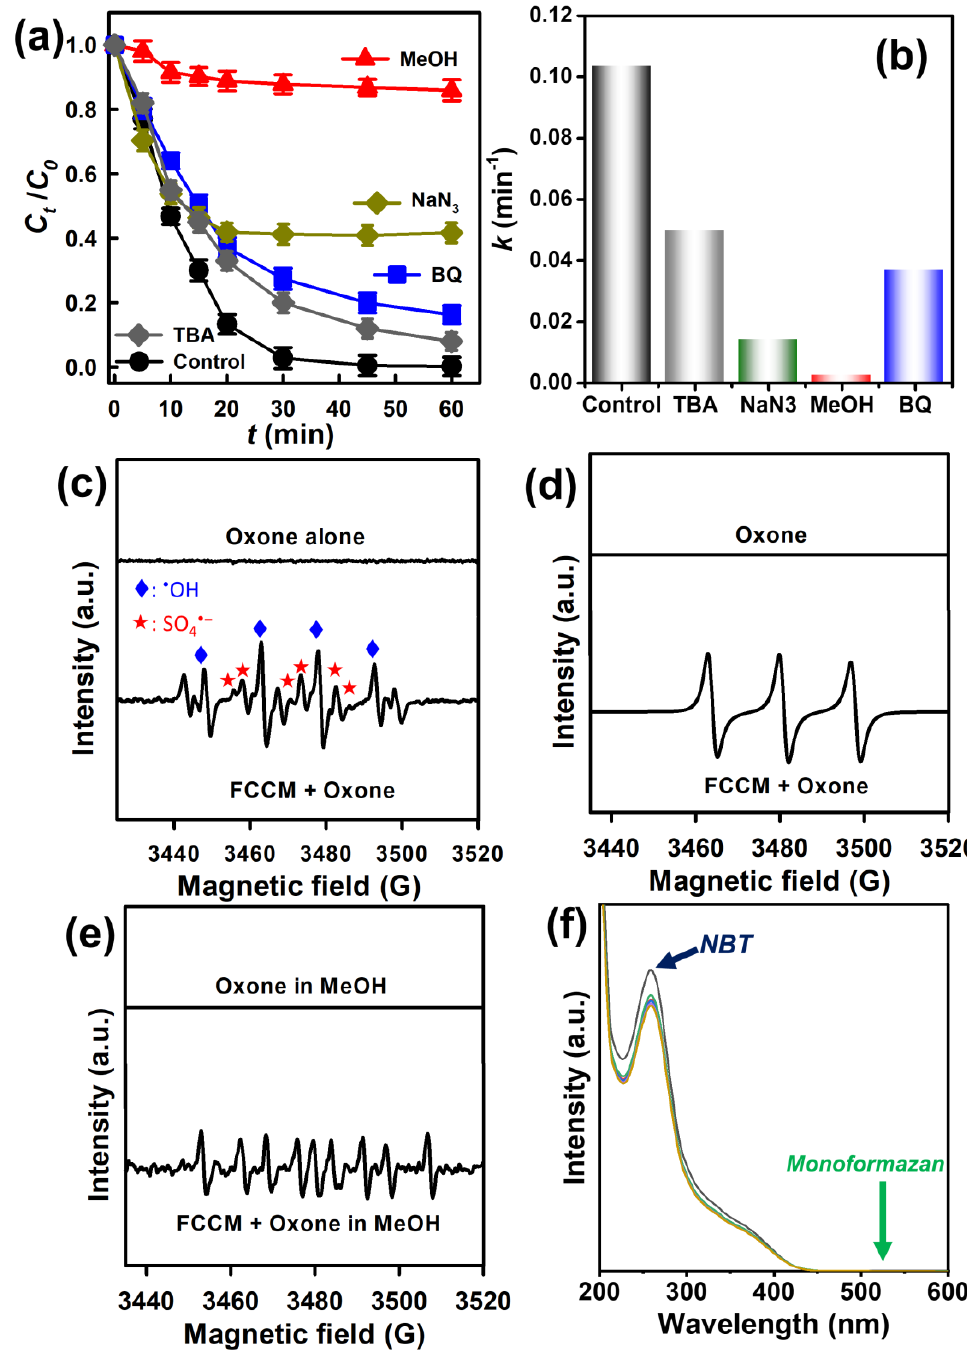
Figure 8. Effects of radical probe on the degradation of AR by the FCCM: ( a ) degradation results, ( b ) rate constants. EPR analyses: ( c ) DMPO, ( d ) TMP, ( e ) DMPO in methanol, and ( f ) NBT test for superoxide (catalyst = 200 mg/L; MPS = 200 mg/L; T = 30 °C).